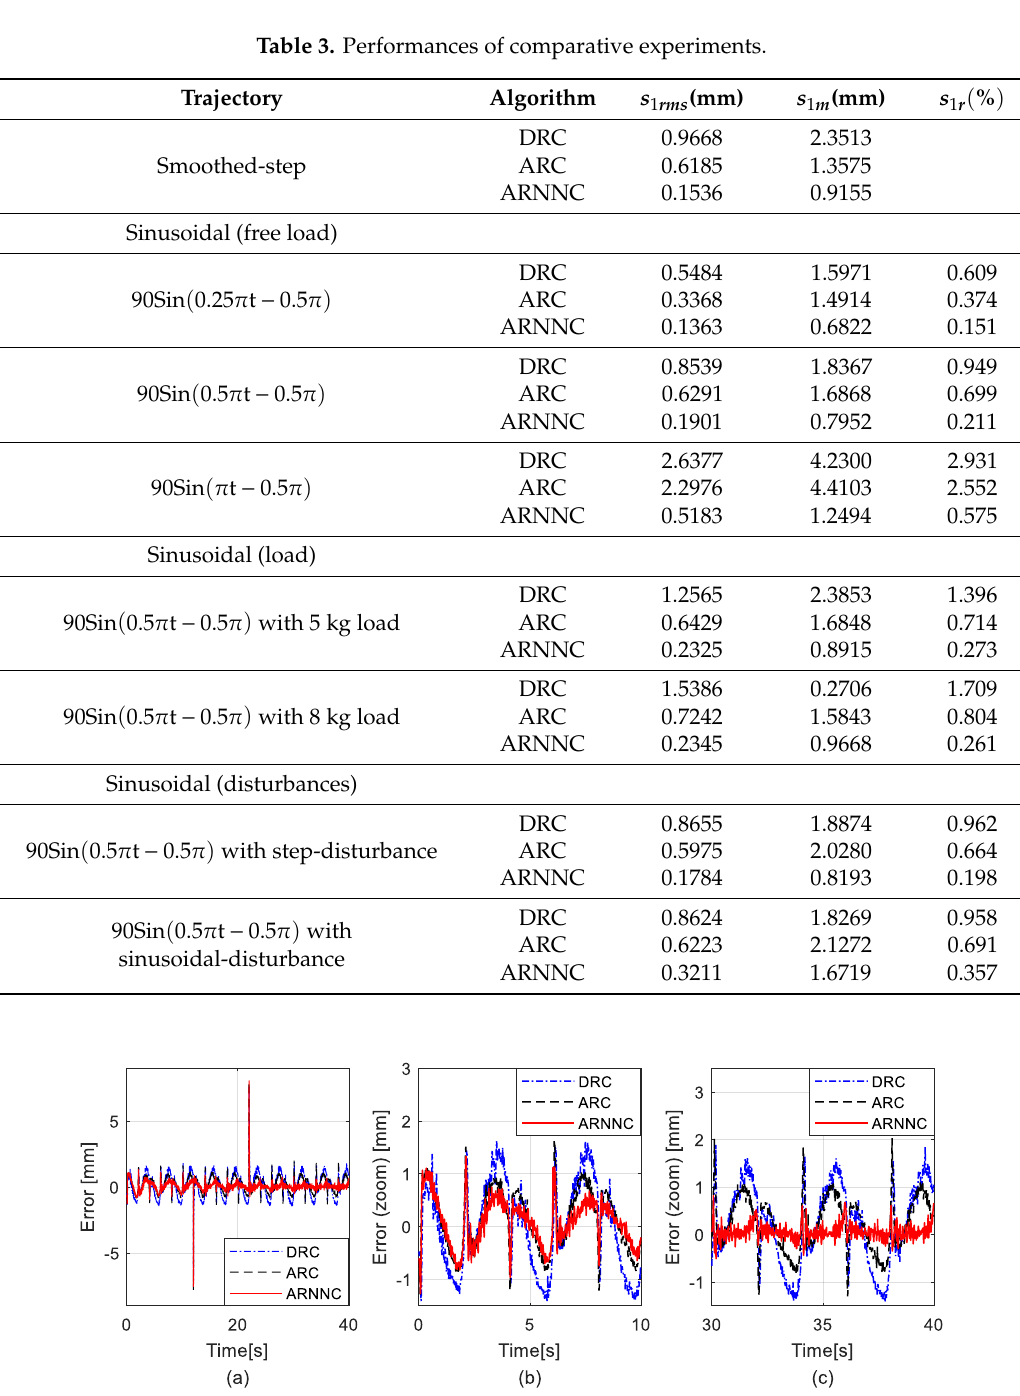
Figure 10. Tracking performances of 90Sin ( 0.5 π t − 0.5 π ) with step-disturbance ( a ) Tracking errors of different controllers. ( b ) Zoomed tracking errors from 0 to 10 s. ( c ) Zoomed tracking errors from 30 to 40 s.